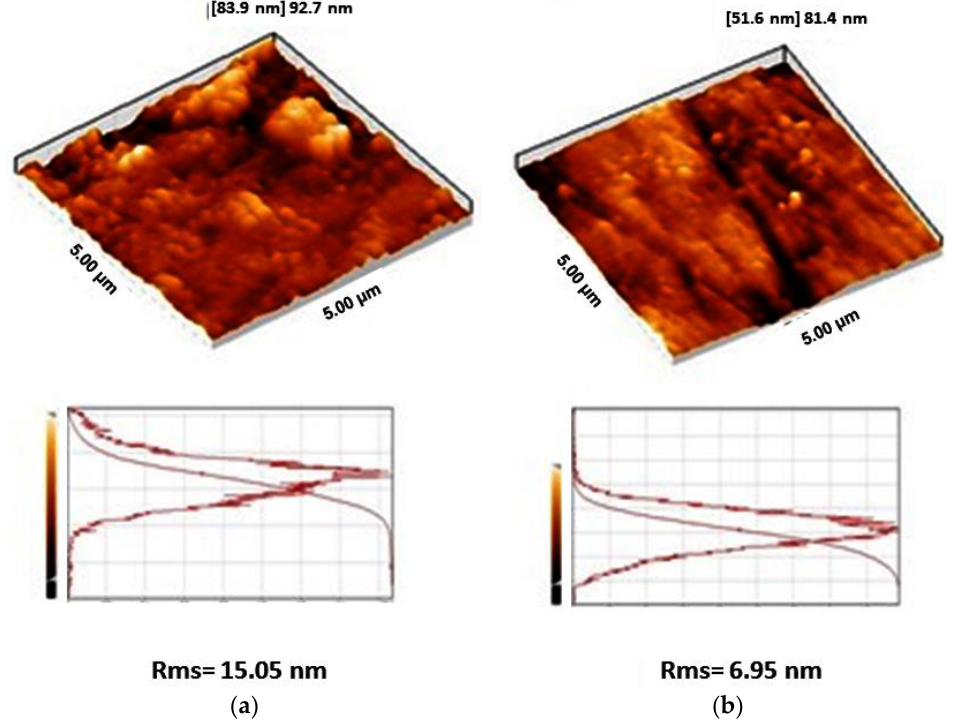
Figure 6. Atomic force microscopy (AFM) images, grain size distribution, and root mean square (rms) roughness values of ( A ) Ti-40 and ( B ) Ti-Nb samples.